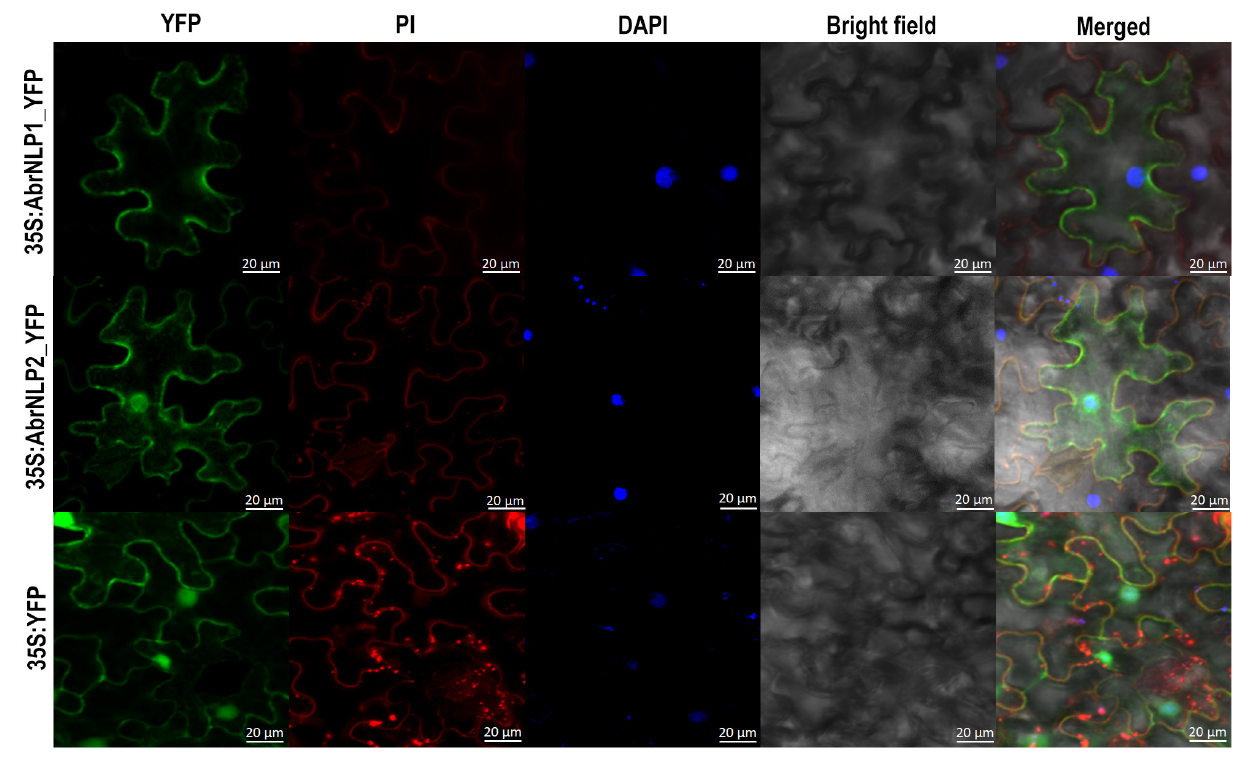
FIGURE 5 | Subcellular localization of YFP-tagged AbrNLP1 and AbrNLP2 in N. benthamiana . Confocal microscopy images of transiently expressed C-terminal YFP-tagged AbrNLPs in N. benthamiana 72 hpi. Full-length YFP was used as a positive control. The leaf sections were stained with DAPI and PI to visualize the nucleus and plant cell wall respectively. Scale bar = 20 µ